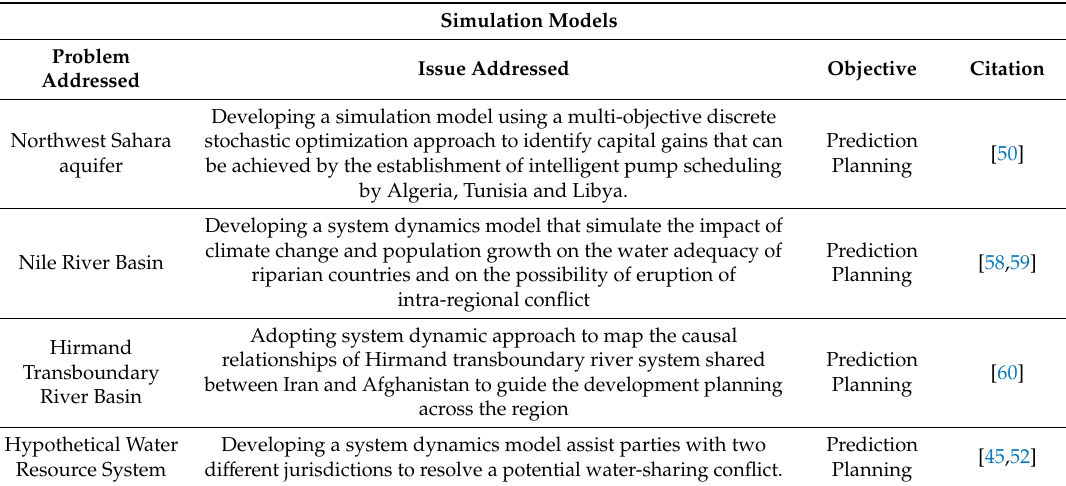
Table 2. Simulation Models—Theory and